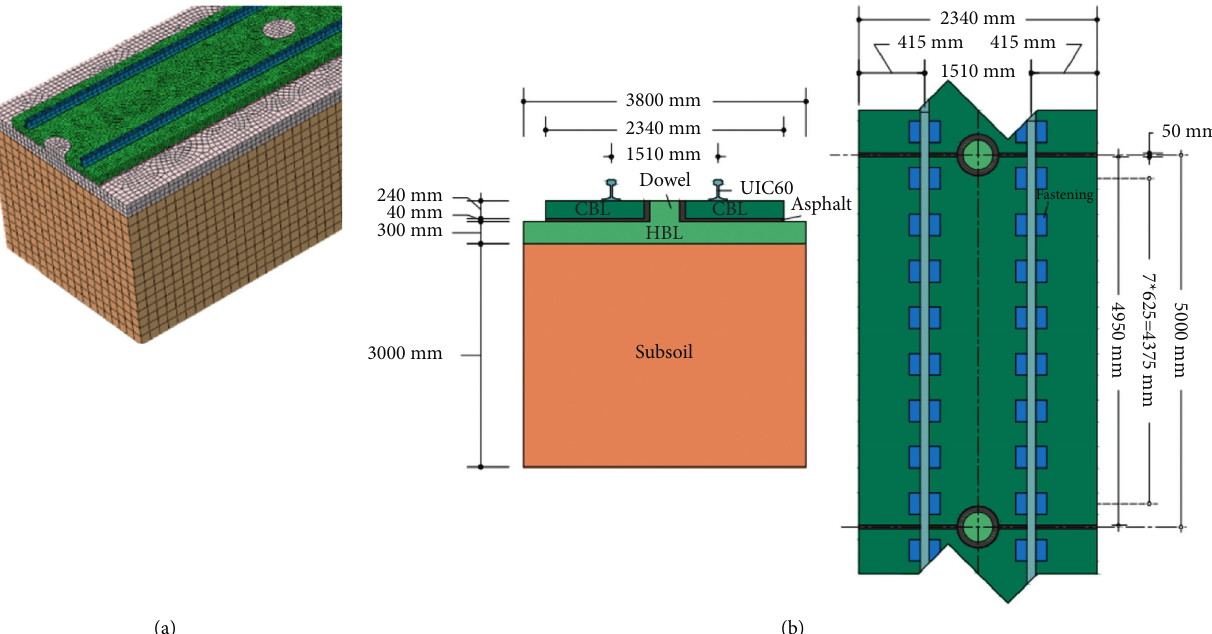
Figure 1: Shinkansen slab track: (a) geometry and dimensions and (b) slab track modeling in